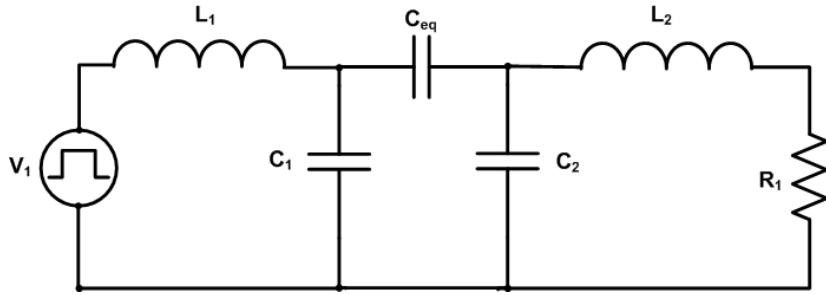
Figure 5. Equivalent Z-Tank modified.